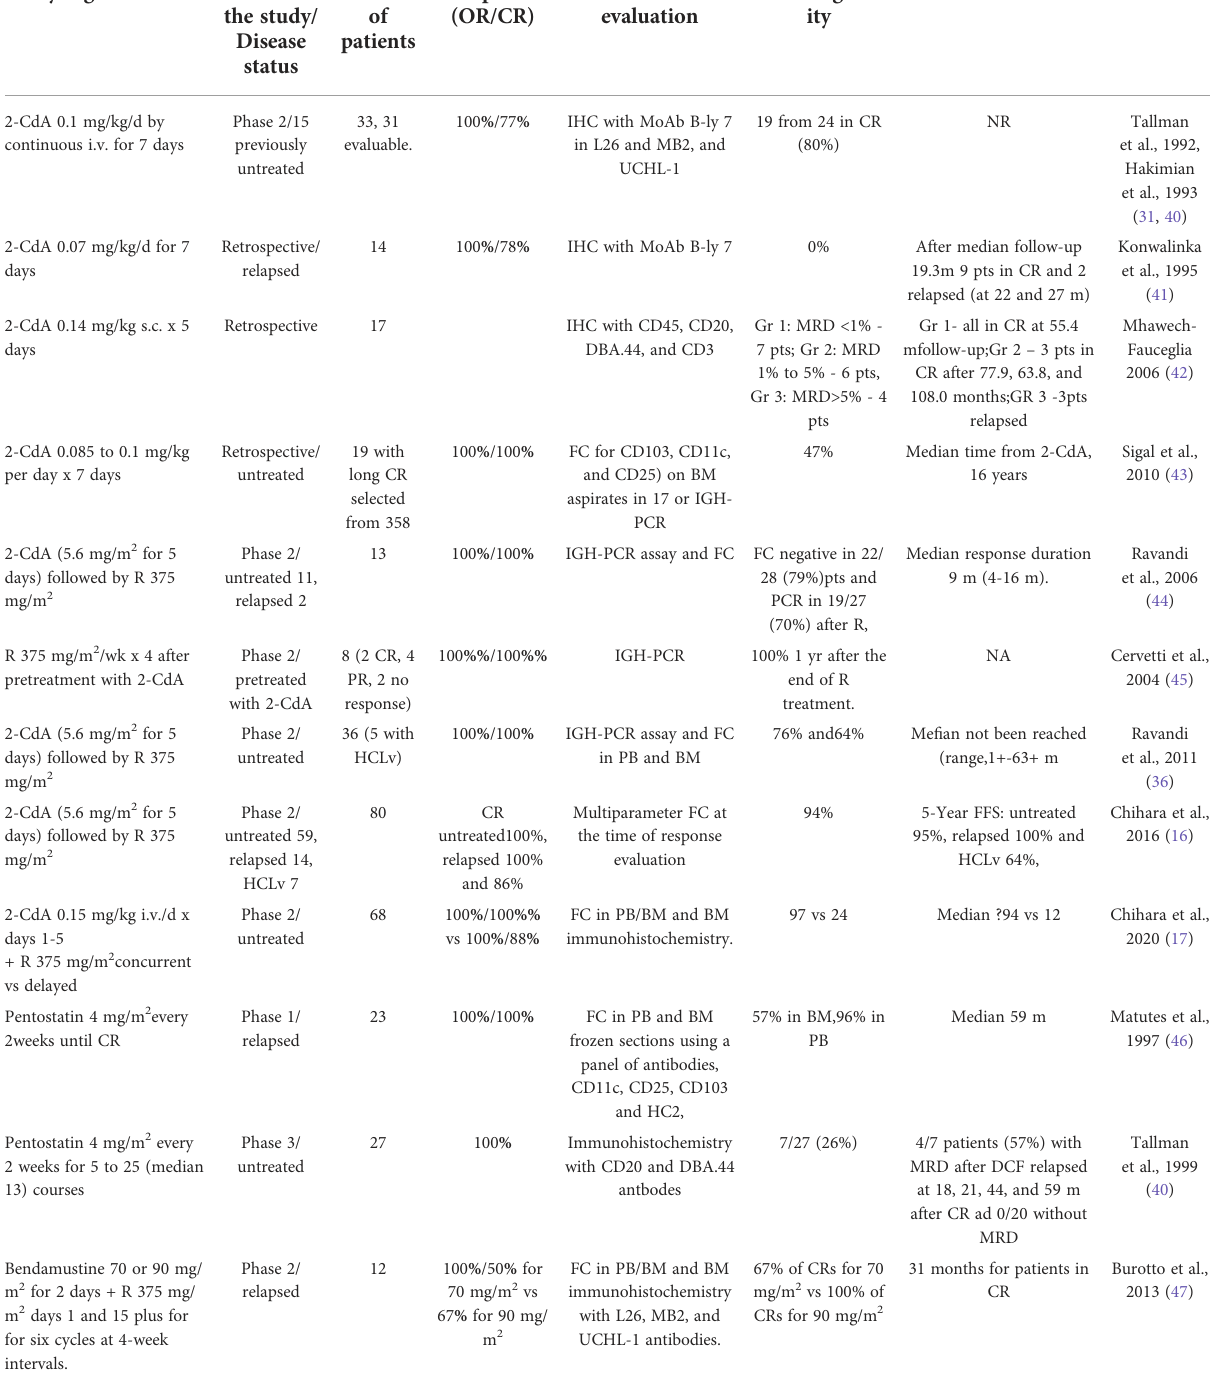
TABLE 1 Clinical studies with MRD evaluation in patients with HCL treated with purine nucleoside